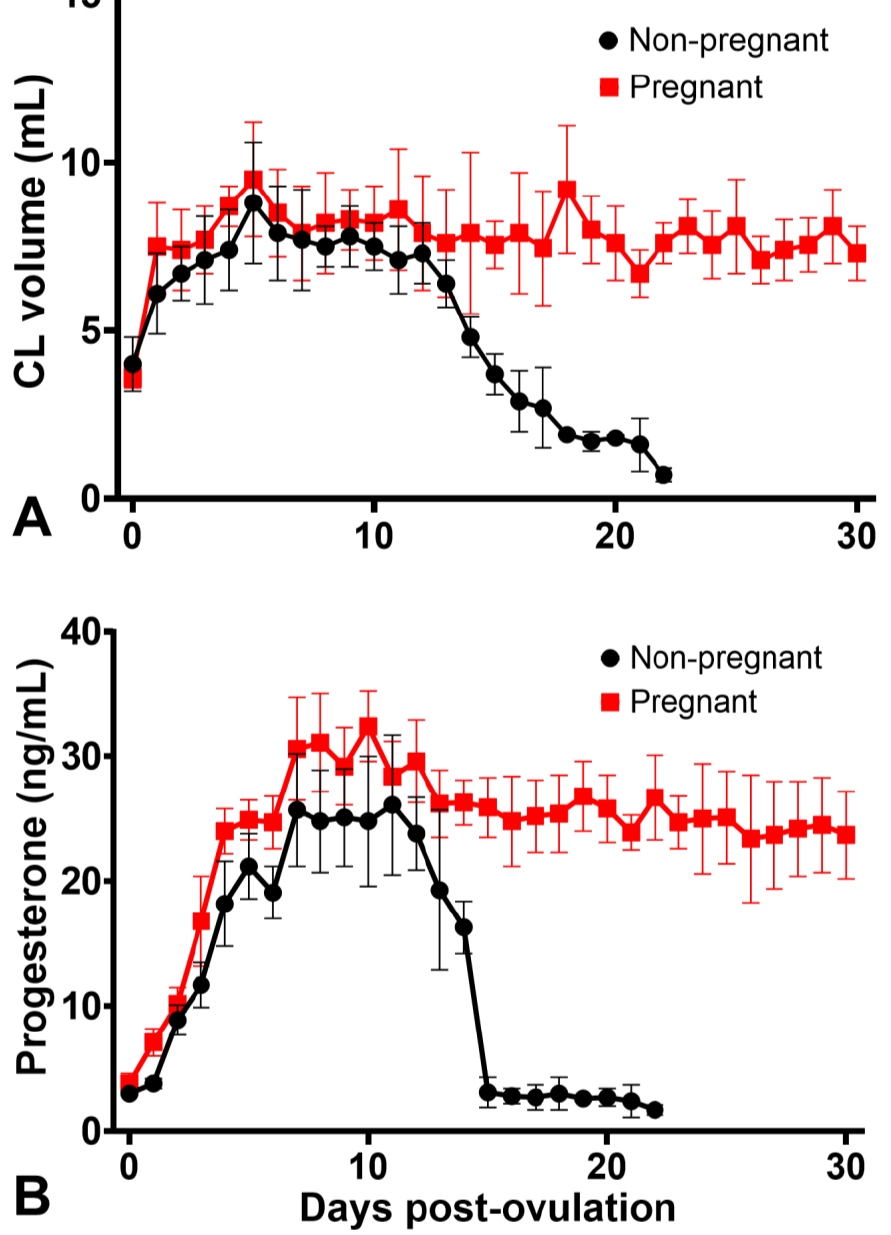
Figure 3. Mean ( ± SEM) corpus luteum (CL) volume ( A ) and serum progesterone concentrations ( B ) after ovulation (Day 0) for pregnant and non-pregnant jennies. Progesterone concentrations were significantly different between jennies and tended to be consistent within jennies; the intraclass correlation coefficient (Day 5–12 after ovulation for non-pregnant cycles) was 0.56 (95% confidence interval: 0.26–0.86), indicating significant repeatability of progesterone concentration within jennies. Progesterone concentrations and CL volume were also moderate related for the first ten days after ovulation (r = 0.51, p < 0.001). While progesterone concentrations differed between reproductive status, luteal volume did not differ between non-pregnant and pregnant cycles ( p =